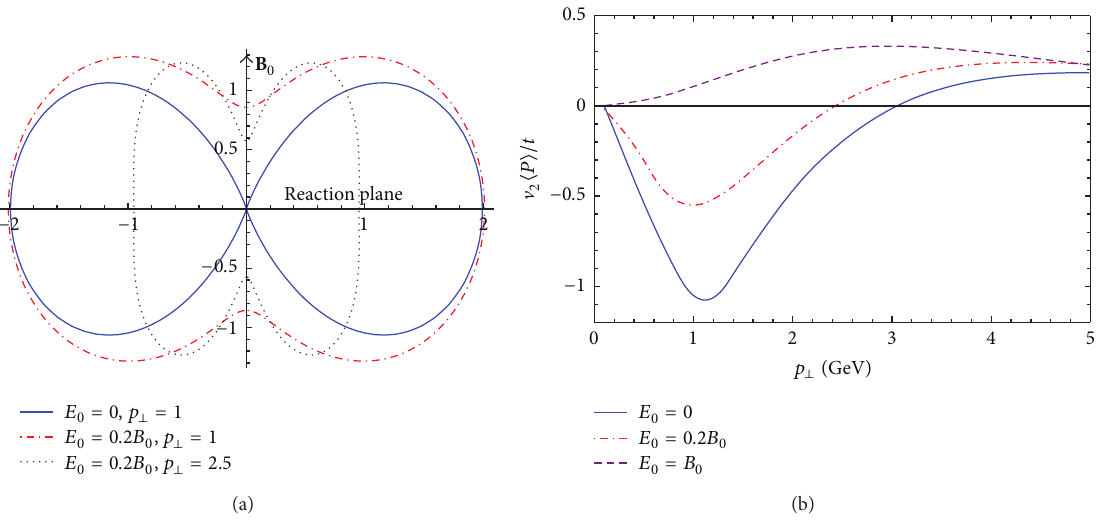
Figure 15: (a) Angular distribution of 𝐽/𝜓 dissociation rate at 𝑒𝐵 0 = 15𝑚 2 𝜋 , 𝜂 = 0 at different 𝐸 0 and 𝑃 ⊥ (in GeV’s). Magnetic field B 0 points in the positive vertical direction. Reaction plane coincides with the horizontal plane. (b) Rescaled second Fourier-harmonic V 2 of the azimuthal distribution as a function of 𝑃 ⊥ . ⟨𝑃⟩ is the azimuthal average of the survival probability, and 𝑡 is the time spent by 𝐽/𝜓 in the 𝑃 -odd